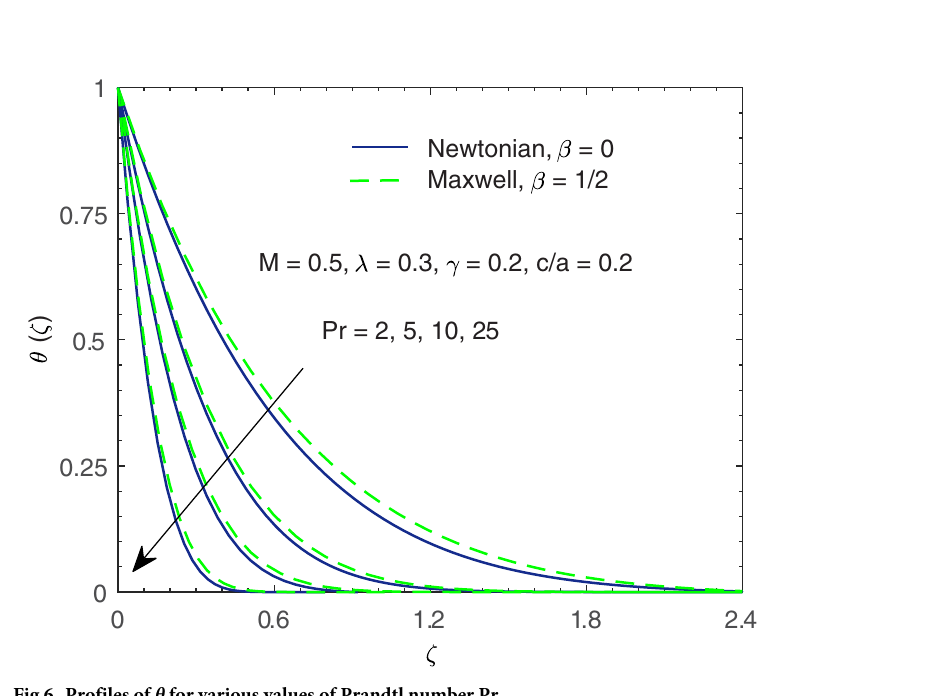
Fig 6. Profiles of θ for various values of Prandtl number